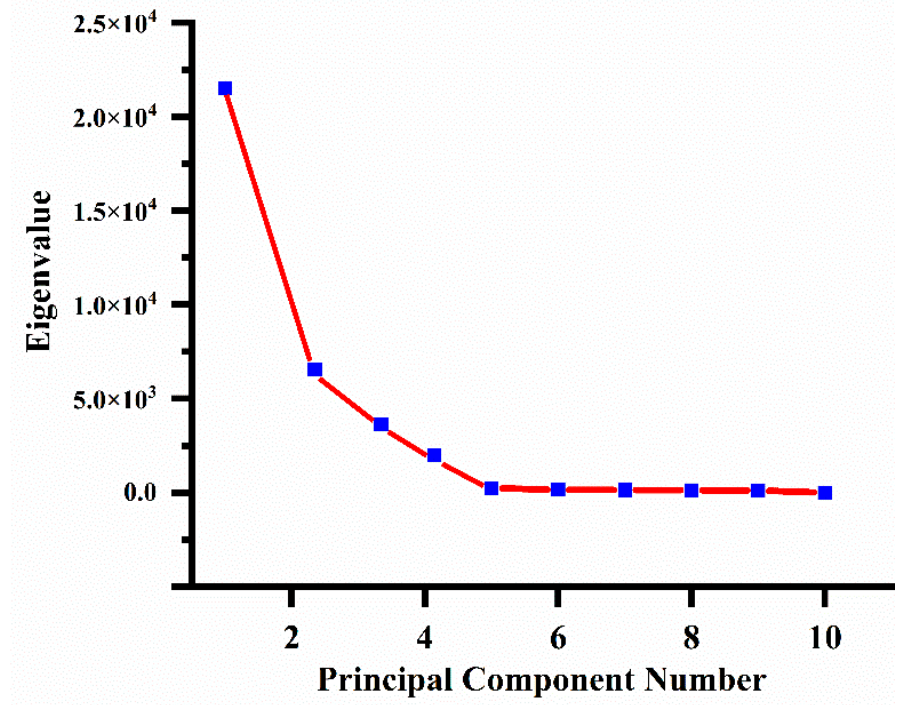
Figure 7. Scree plot of the PCA analysis using averaged LIBS data.